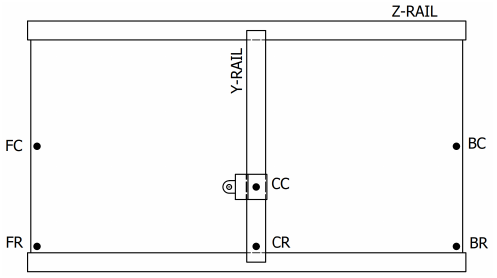
Figure 11. Measure positions for the cutting head, where F = front, C = center, B = back, and R =